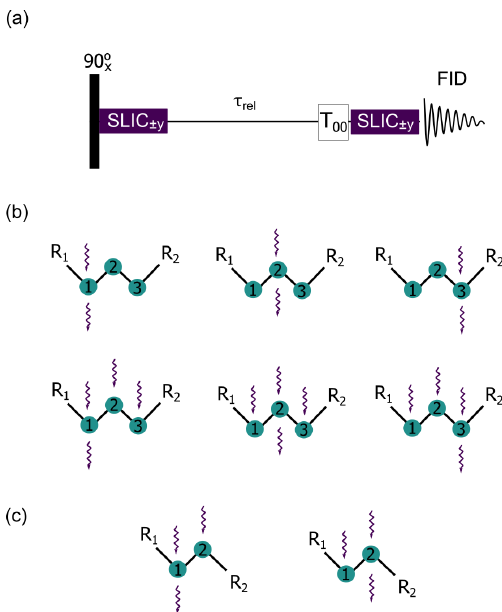
Figure 2. (a) Generic pulse sequence for single and poly-SLIC where selective RF fields can be applied simultaneously to two or more CH 2 groups. (b) Six possible poly-SLIC experiments applied to molecules containing three CH 2 groups such as I and II of Fig. 1a. The upper row shows three experiments with irradiation at a sin- gle frequency for the creation of LLSs and a single readout pulse applied to the offset of the first, second, or third CH 2 group; the lower row shows three experiments using triple irradiation of all three CH 2 groups for LLS excitation, combined with a single read- out SLIC applied to only one of the three CH 2 groups. (c) Two schemes with double SLIC excitation and single SLIC readout for compounds containing only two CH 2 groups such as III and IV of Fig.